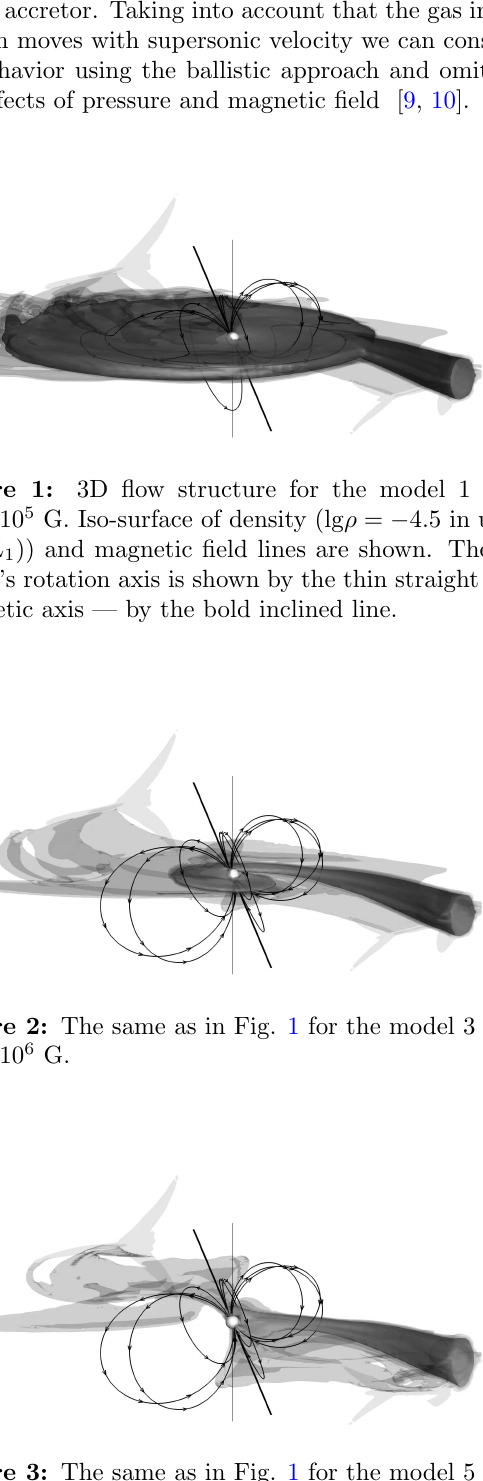
Figure 3: The same as in Fig. 1 for the model 5 with B a = 10 7